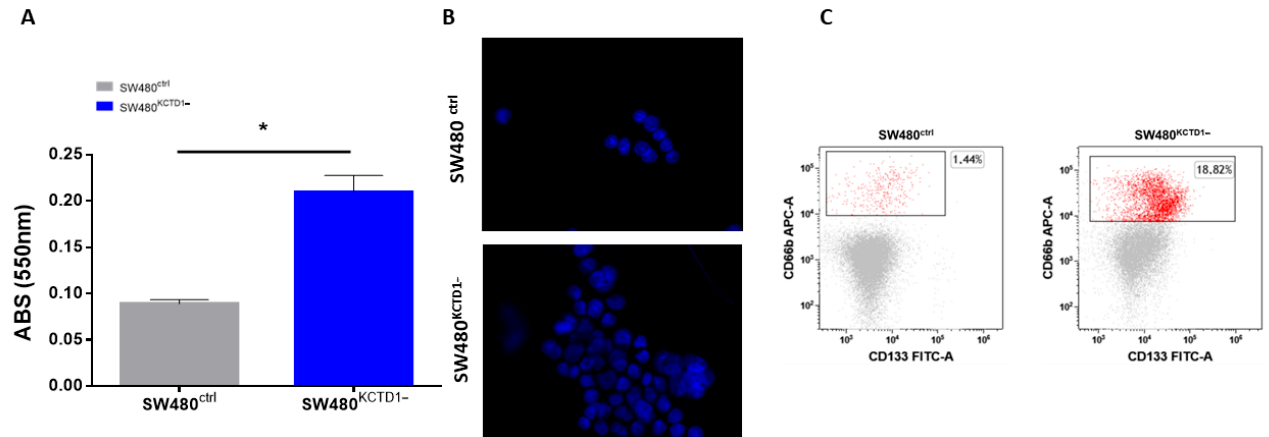
Figure 3. ( A ) SW480 ctrl and SW480 KCTD1 − cells were allowed to invade the Transwell insert for 24 h. Invading cells were stained with crystal violet and the signal recorded by measuring absorbance at 550 nm. Cells were also photographed after staining the nuclei with DAPI ( B ). CD66-APC VS CD133-FITC dot plots of SW480 ctrl and SW480 KCTD1 − cells ( C ). Percentage of gated cells. Bars represent the mean of triplicate experiments ± standard deviations. * = p < 0.05.